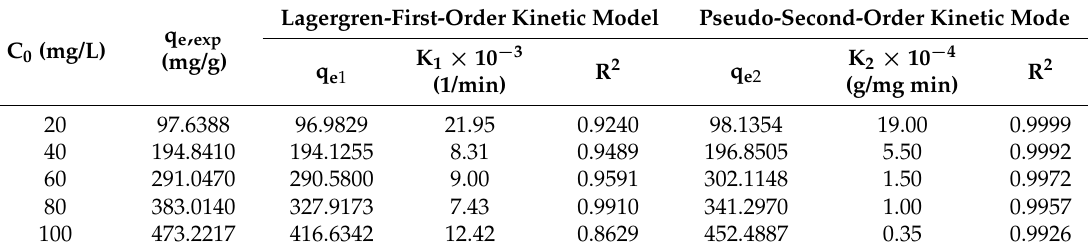
Figure 7. ( a ) Lagergren-first-order kinetic model, ( b ) pseudo-second-order kinetic model and ( c ) intra-particle diffusion model for adsorption of MB onto CNC-g-AA-2-120-8 aerogels at 25 ◦ C. Table 1. Adsorption kinetic parameters for MB adsorption of CNC-g-AA-2-120-8